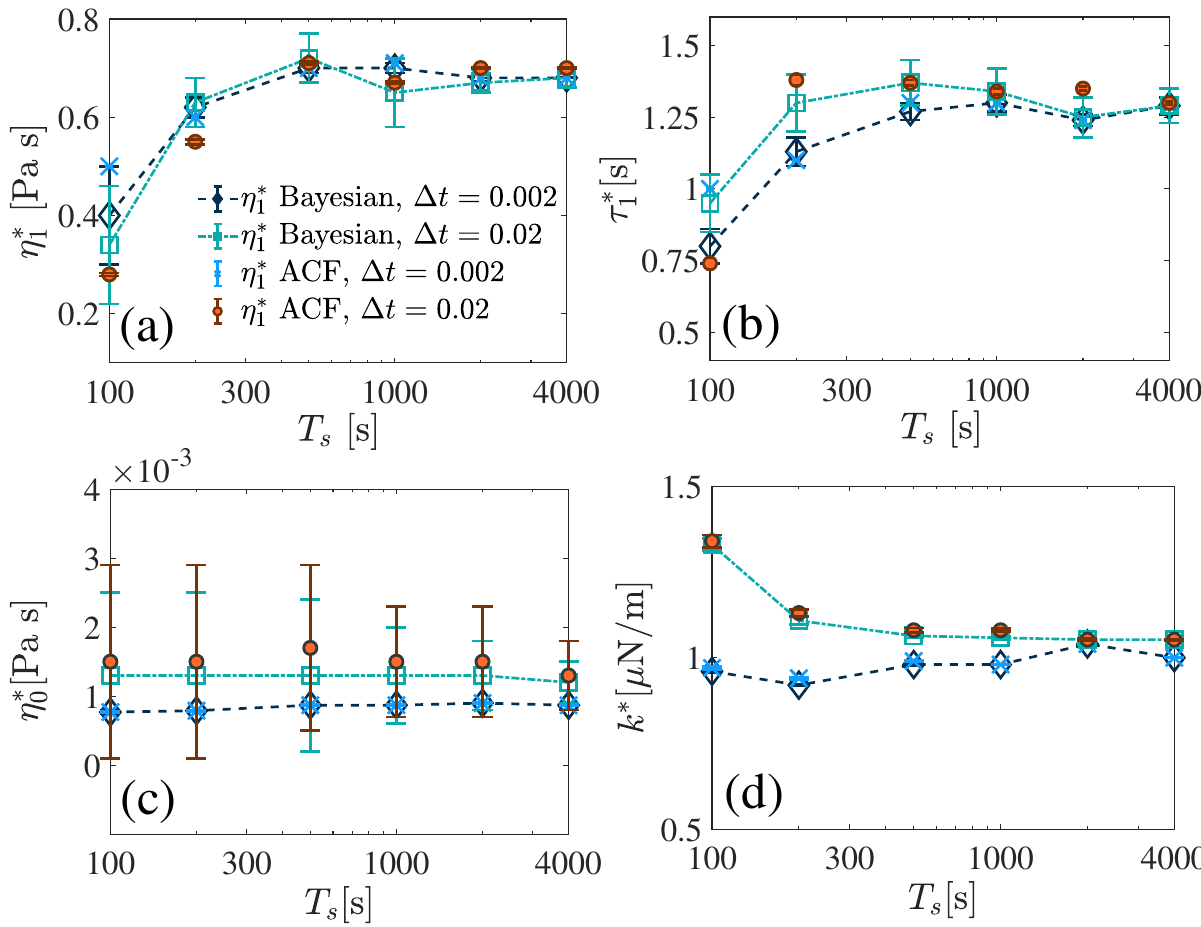
Figure 4. MAP estimations of the parameters from the thermal position fluctuations of a trapped particle in a viscoelastic fluid ( 0.06 %w / w PAAM-water) for various T s and (cid:31) t